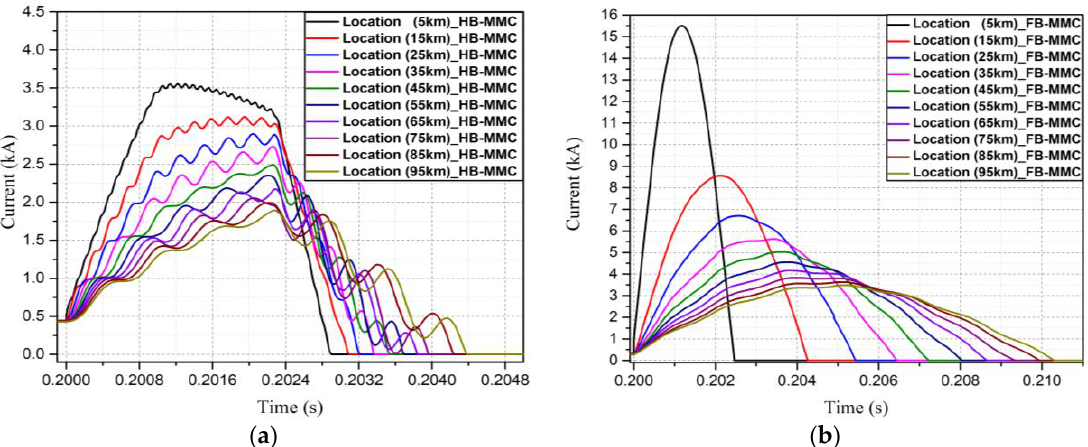
Figure 8. Fault handling interruption performances: ( a ) fault current interruption characteristic of Case-1 with an HCB; ( b ) fault current interruption characteristic of Case-2 with an RCB.